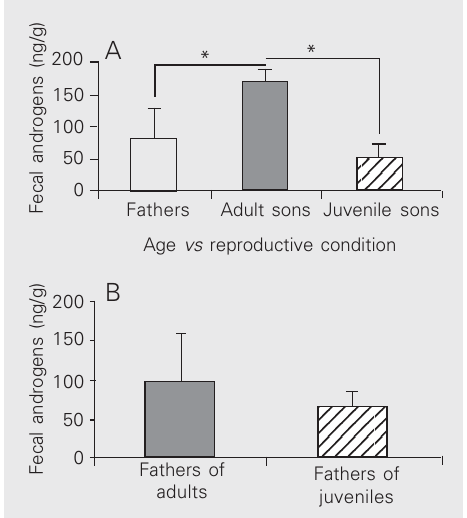
Figure 2. A , Fecal androgen lev- els for adult reproductive males (fathers, N = 6) and non-repro- ductive males (adult sons, N = 3; juvenile sons, N = 3). Data are reported as means ± SEM. *P < 0.05 for adult sons vs fathers and adult vs juvenile sons (Stu- dent t -test). B , Fecal androgen levels for fathers according to the age of the sons, i.e., fathers living with adult sons (N = 3) and fathers living with juvenile sons (N = 3). Data are reported as means ± SEM. The fathers did not differ in fecal androgen ex- cretion (Student t